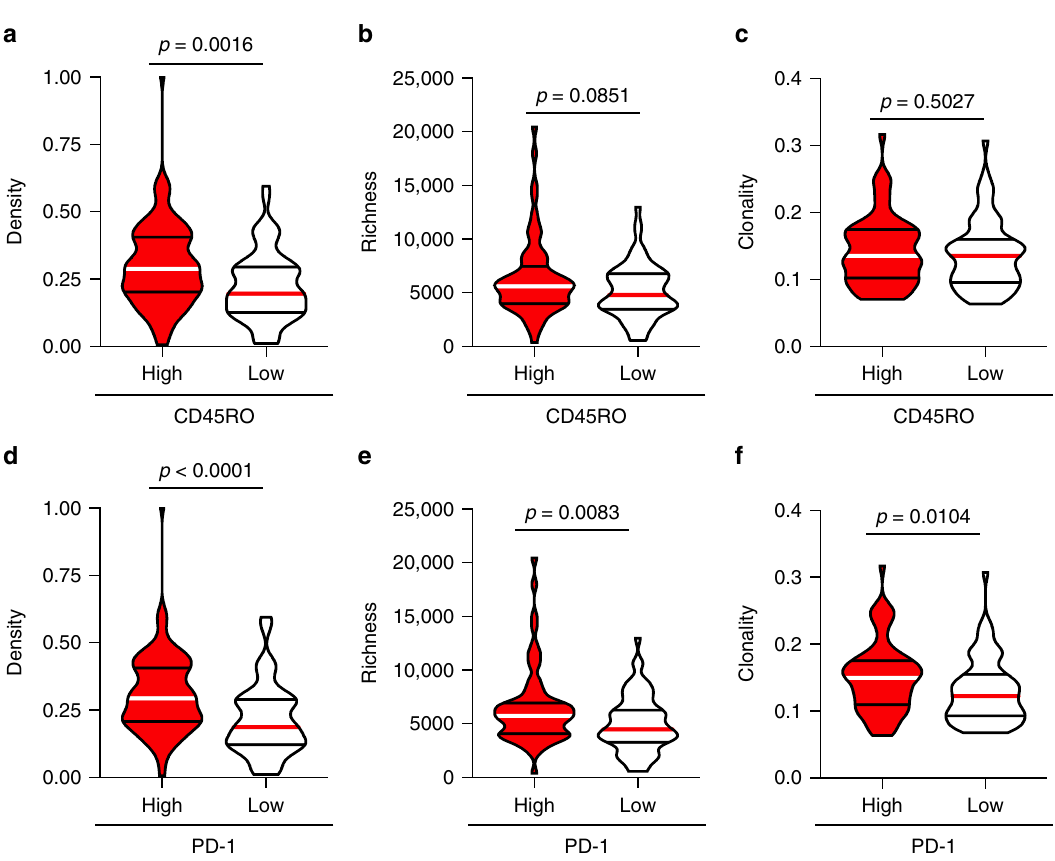
Fig. 2 T cell density, richness and clonality are enriched in PD-1 hi tumors. ( a ) T cell density ( n = 135), ( b ) richness ( n = 134) and ( c ) clonality ( n = 135) in CD45RO hi and CD45RO lo tumors. ( d ) T cell density ( n = 135), ( e ) richness ( n = 134) and ( f ) clonality ( n = 135) in PD-1 hi and PD-1 lo tumors. Bars represent median and